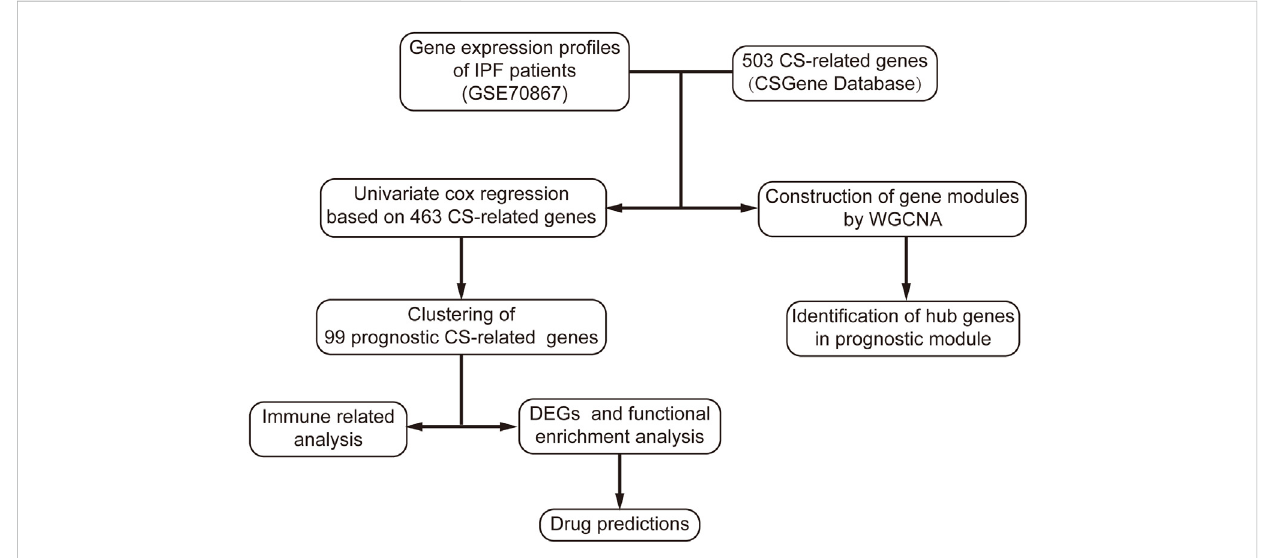
FIGURE 1 Flow chart of research process in this study. CS, cellular